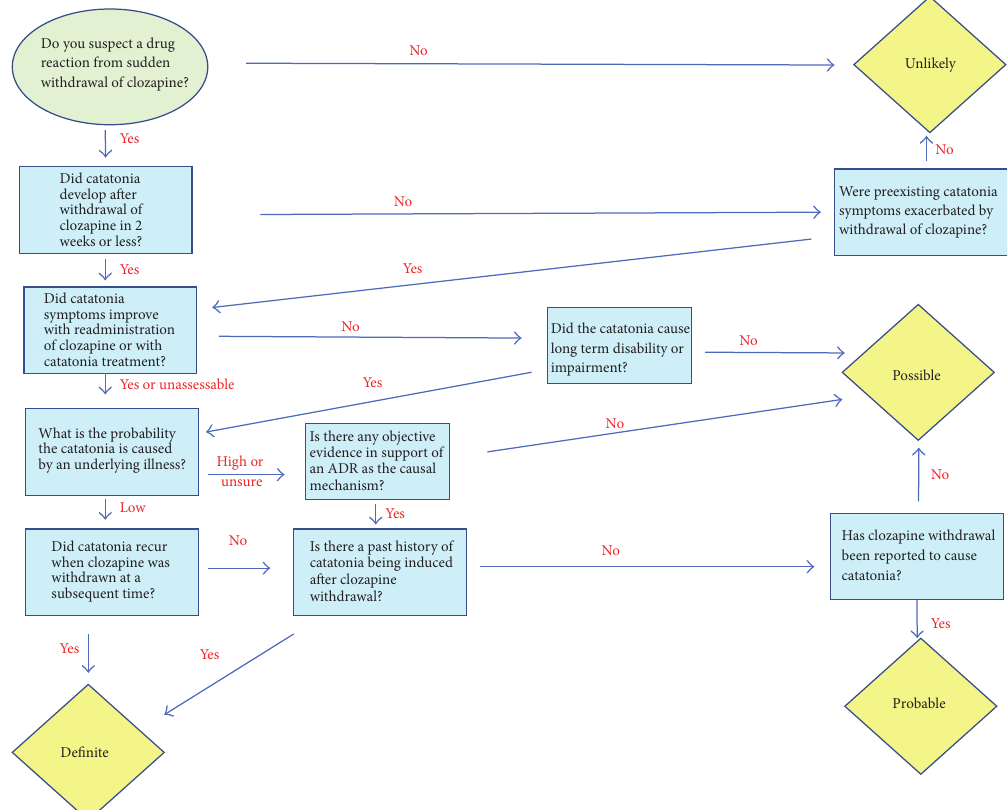
Figure 1: Modification of the Liverpool Adverse Drug Reaction Causality Assessment Tool [25] to retrospectively assess the likelihood that clozapine withdrawal caused the catatonia